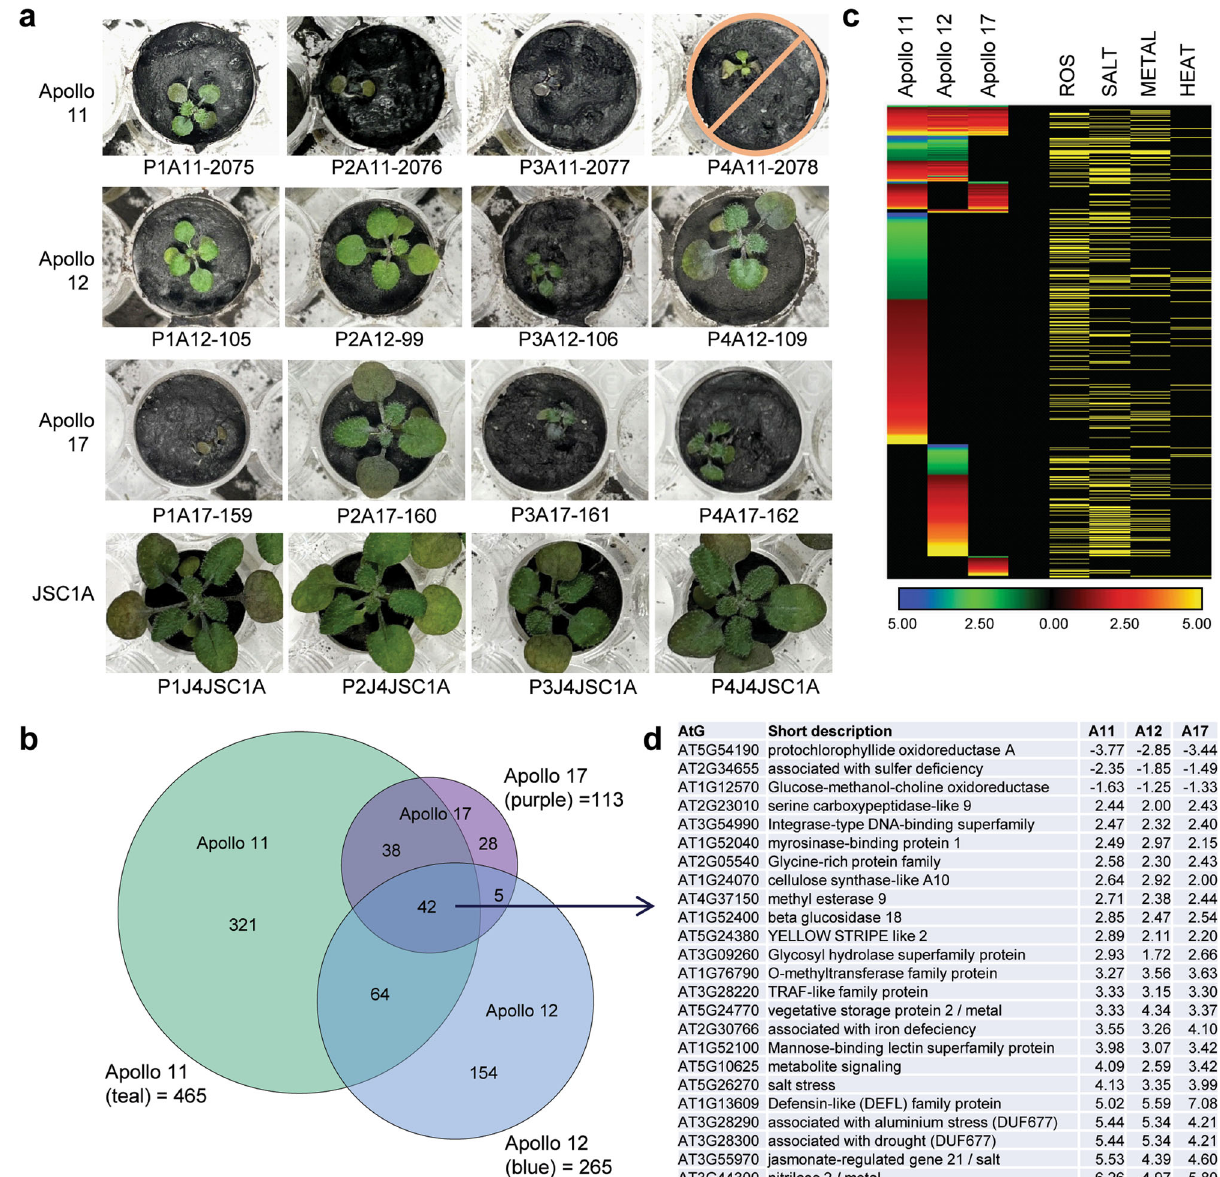
Fig. 3 Transcriptome analyses of plants grown in lunar regolith grouped by Apollo site. a Three (Apollo 11) to four (Apollo 12, 17) plants from each site comprised the analyses. One Apollo 11 plant did not survive and was excluded from the DEG analysis. The photographs were taken just prior to harvest. b Venn diagrams showing the DEG overlap for plants from each site: teal for Apollo 11, blue for Apollo 12, and purple for Apollo 17. c Heat maps show the Log2 fold-change of DEGs in plants from each site. Genes associated with ROS, salt, metal, and heat responses are indicated by yellow rows. These associations were primarily derived from the stress transcriptomes and data sets presented in References ( 37 – 40 ) and NCBI gene annotations (https://www.ncbi.nlm.nih.gov/gene/823555). d 25 of the most highly differentially expressed genes common to all Apollo sites with fold-change presented as Log2. The fully annotated heat map (3 C) is provided as Supplementary Data 1, and the complete, fully annotated list of 3D is provided in Supplementary Data